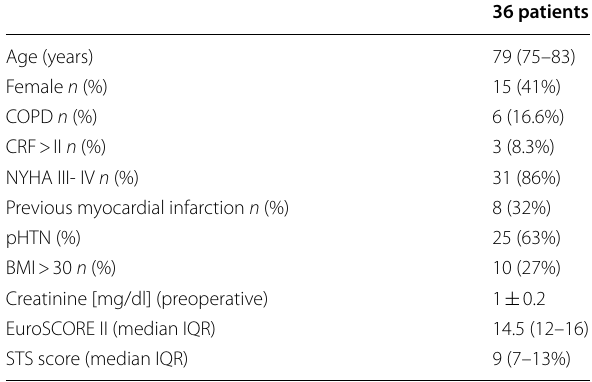
Table 1 Baseline characteristics of study